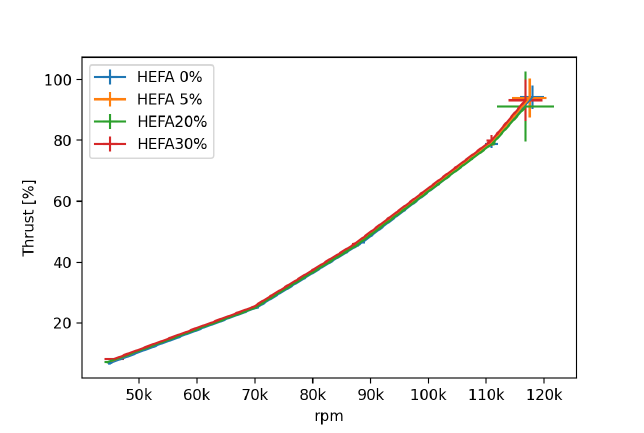
Figure 17. GTM-140/HEFA: Thrust.